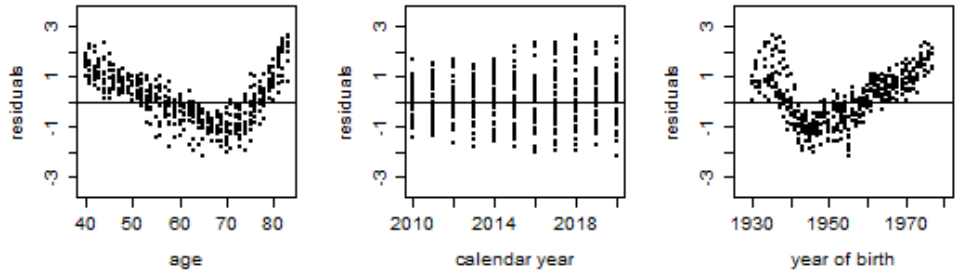
Figure 9. CBD Deviance Residuals from the Fitted Model to the Ghana Pension Population for Ages 40–83 and the Period 2010–2020.